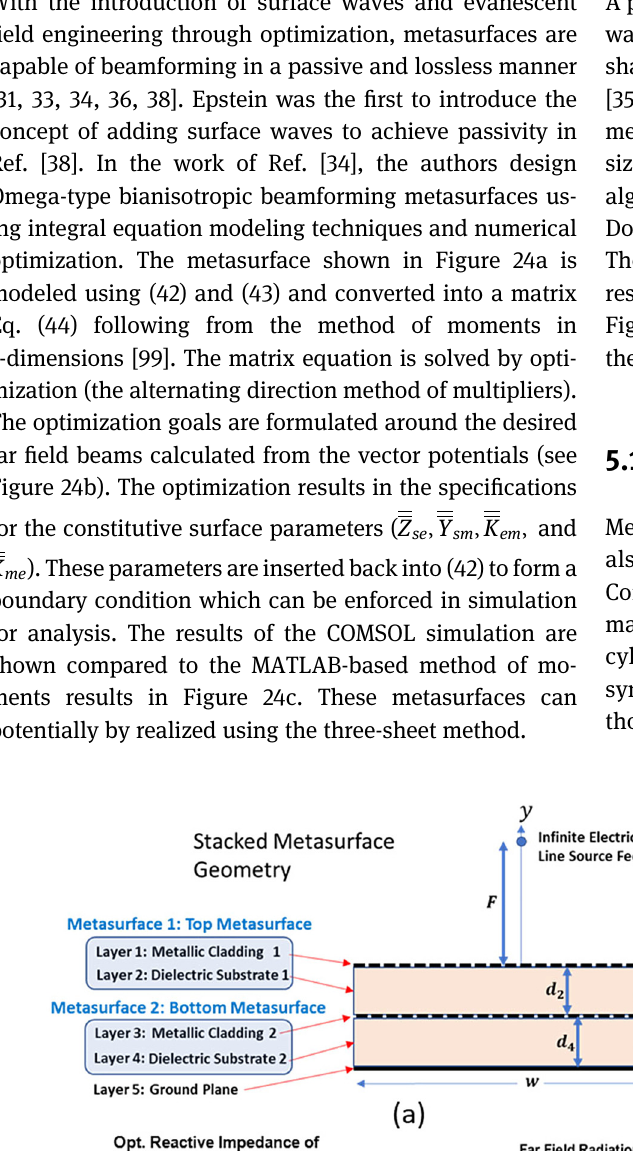
Figure 27: (Reprinted with permission from Ref. [57]). (a) Dual band